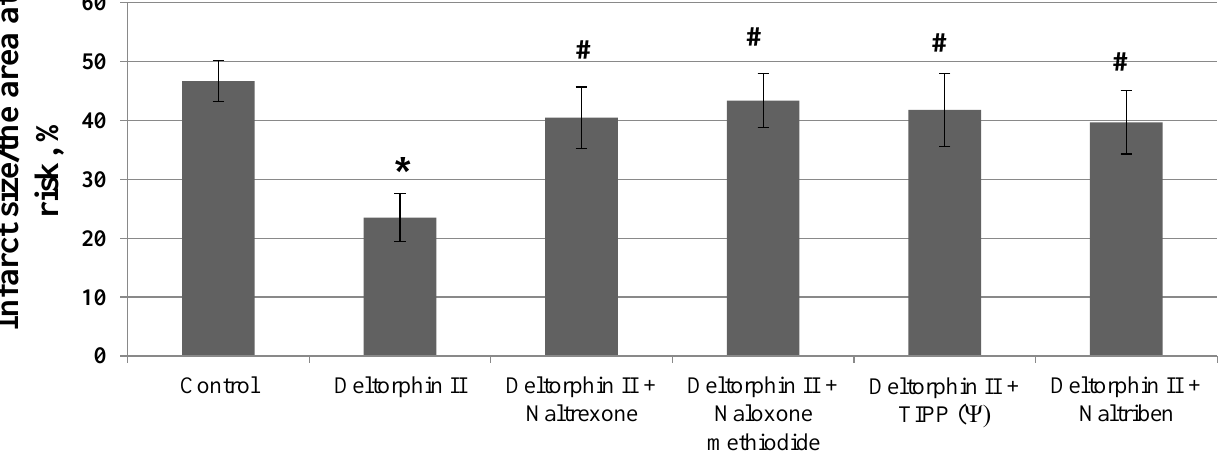
6 of 12 Figure 1. Effect of opioid receptor antagonists on the infarct size/area at risk ratio ( Y -axis). Data